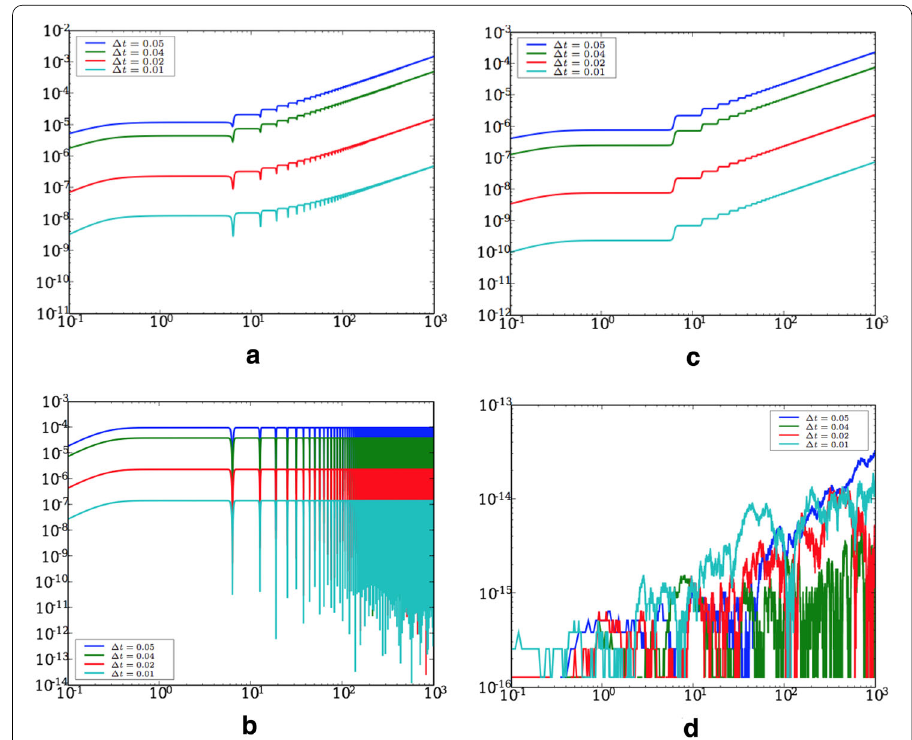
Fig. 6 Kepler’s problem. Relative error on H and on (cid:10) with the Runge–Kutta schemes. a Error on H with RK4. b Error on H with RK4sym. c Error on (cid:10) with RK4. d Error on (cid:10) with RK4sym